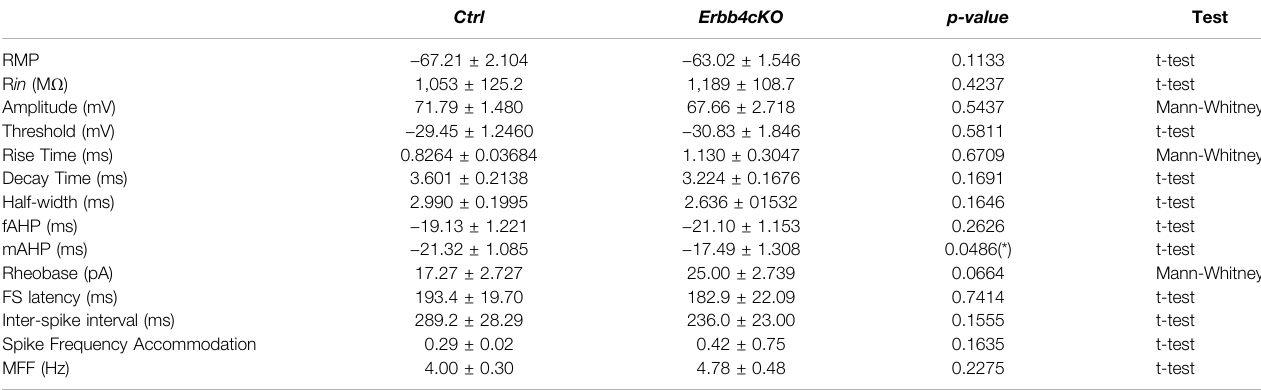
TABLE 1 | Global intrinsic excitability of Pet1 +tdTomato+ neurons in the dorsal raphe is not affected by ErbB4-de fi ciency in serotonergic neurons. Intrinsic electrophysiologicalpropertiesof Pet1 +tdTomato-expressingneuronsinthedorsalraphenucleusofcontroland Erbb4cKO mice.V rest :restingmembranepotential;R in